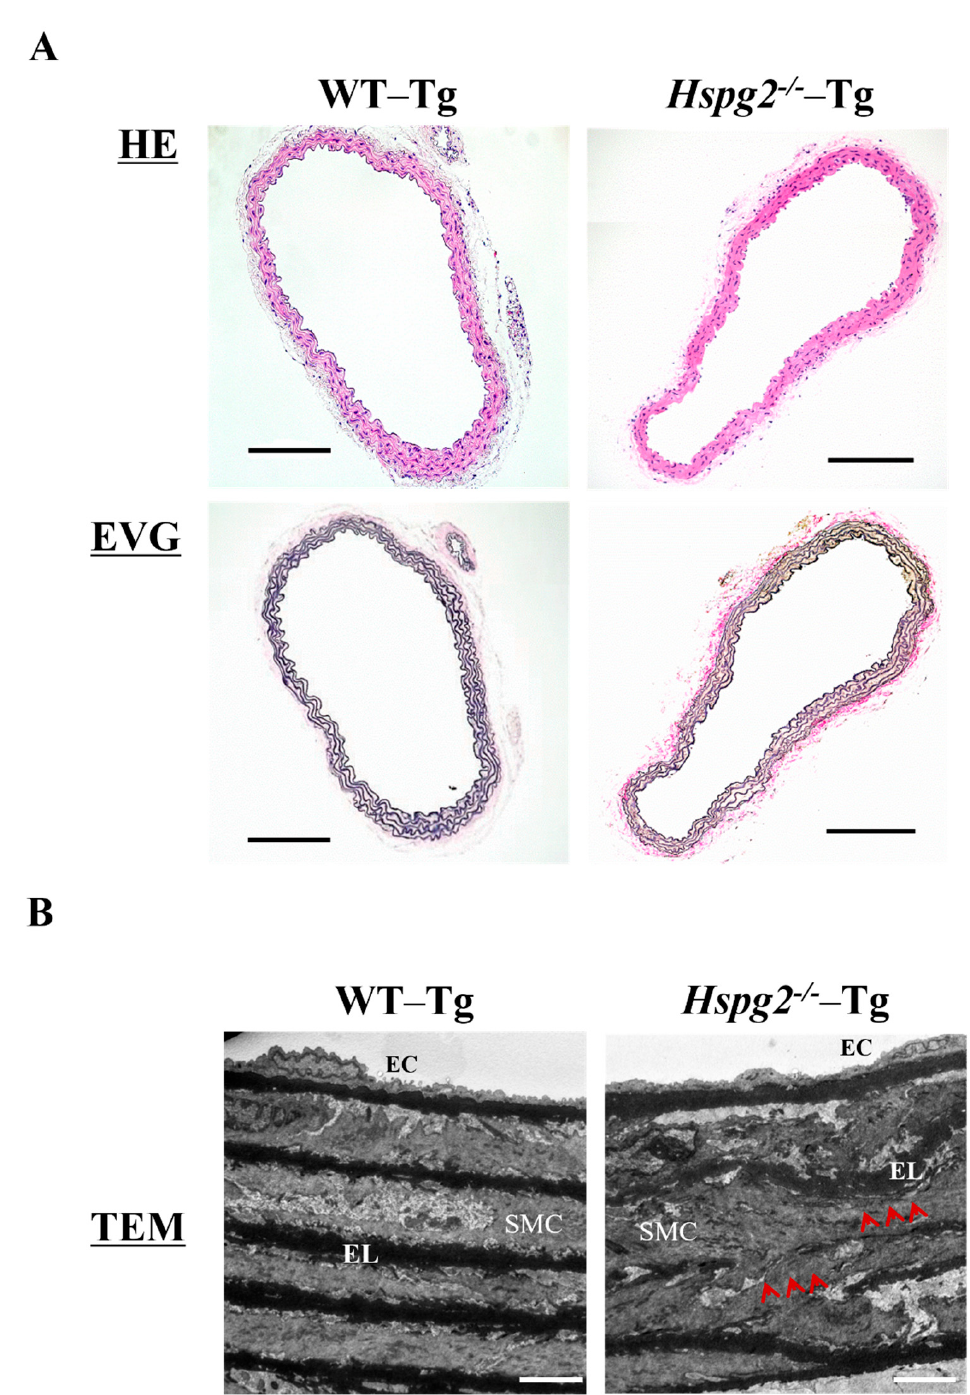
Figure 3. Histological and morphological analyses of aortic tissue in Hspg2 − / − -Tg mice indicated the absence of aortic dissection (AD). ( A ) HE staining and EVG staining showed no significant differences in the aortic tissue morphology of Hspg2 − / − -Tg mice compared to that of WT-Tg, with no AD at 10 weeks of age (Scale bar = 100 µm, n = 6). ( B ) TEM analysis showed that the elastic lamina (EL) in Hspg2 − / − -Tg mice was partially torn and thinner (red arrows) than that in the WT-Tg mice. (Scale bar = 5 µm, n = 3). These images are typical.